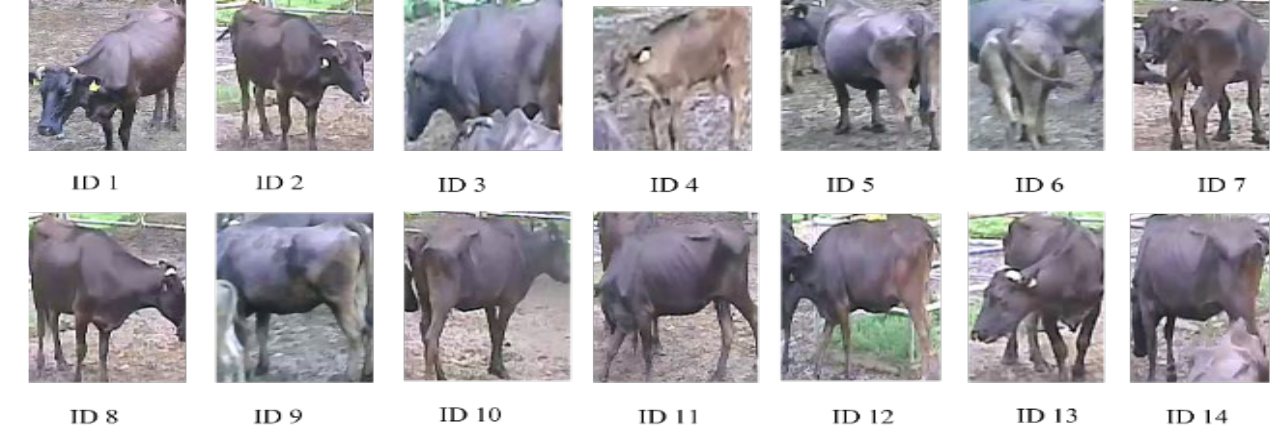
Figure 6. A sample of the cattle Re-ID dataset .